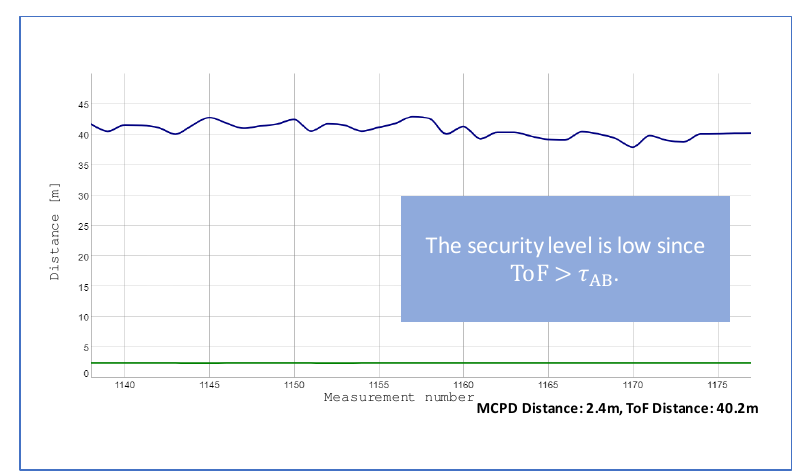
Figure 20: MCPD- and ToF-based distance measurements under relay